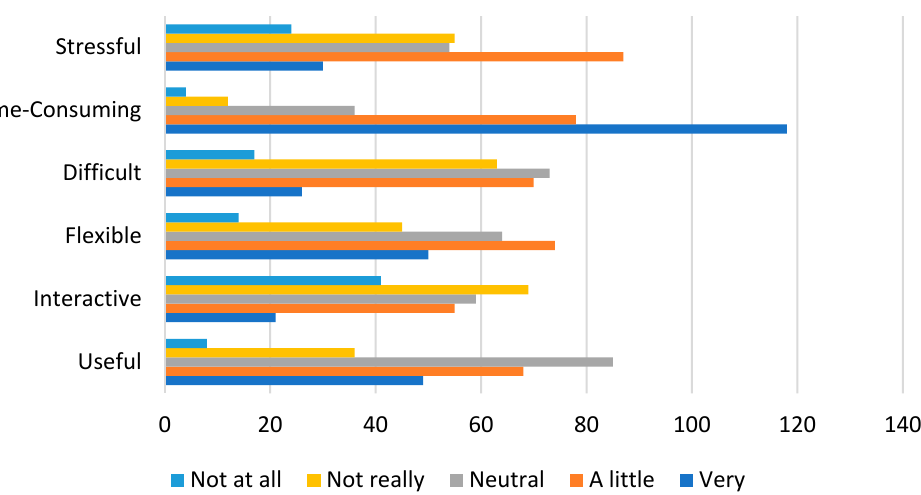
Figure 2. Responses to the survey question: “How did you find online teaching by the end of the semester?” ( n = 245–250).